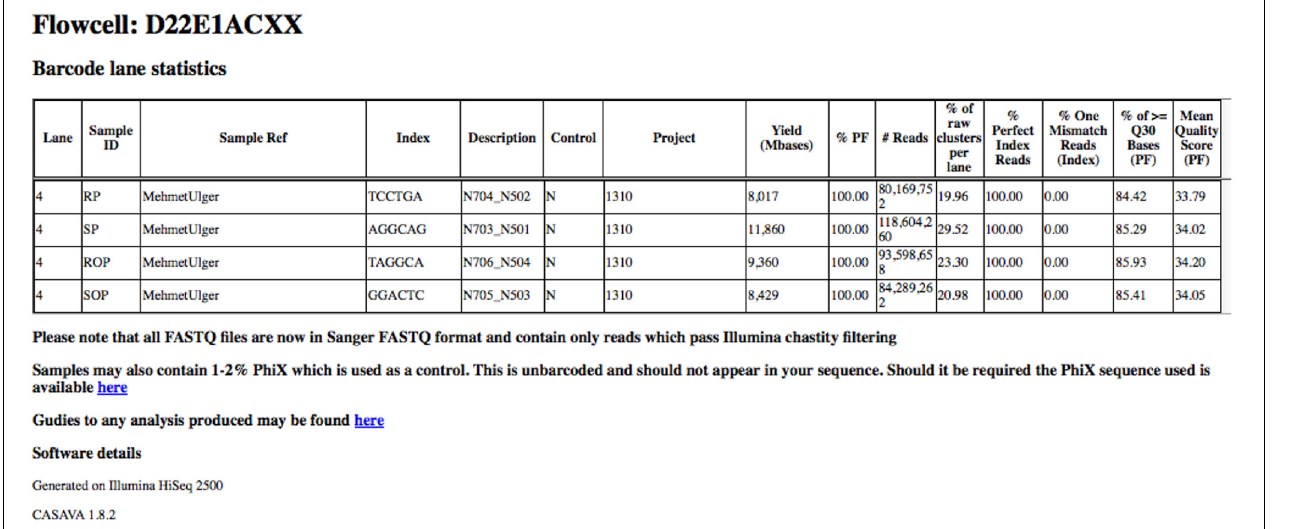
FIGURE 3 | Basic read metrics extracted on a per-project basis. Basic read metrics extracted on a per-sample basis from the Illumina Demultiplex_stats. html file produced by the bcl2fastq pipeline. Additional information has also been added.